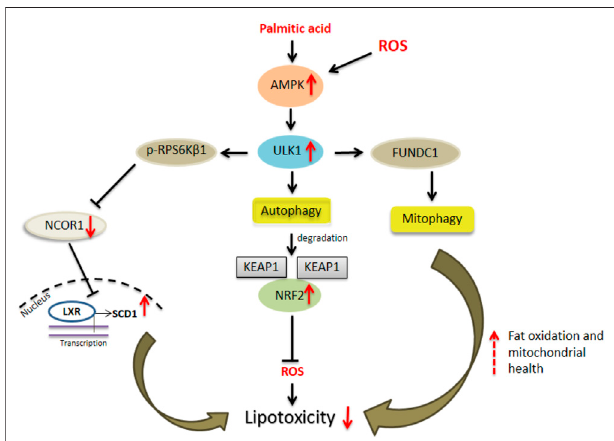
FIGURE 1 | ULK1 and hepatic lipotoxicity. Uncoordinated-51-like kinases 1 (ULK1) via both autophagic and non-autophagic mechanisms limit cytotoxicityinducedbysaturatedfatsandoxidativestressinhepatocytes.The autophagy dependent mechanisms include selective degradation of damaged mitochondria or “ mitophagy ” and secondly by degradation of kelch like ECH associated protein 1 (KEAP1) thereby activating nuclear factor erythroid 2 like factor 2 (NRF2) anti-oxidant response. A non-autophagic pathway includes inhibition of ribosomal protein S6 kinase, polypeptide 1 (RPS6KB1)- nuclear receptor co-repressor 1 (NCOR1) signaling and thereby relieving liver X receptors (LXRs) mediated stearoyl-coenzyme A desaturase 1 (SCD1) transcription leading to conversion of saturated fats to their unsaturated